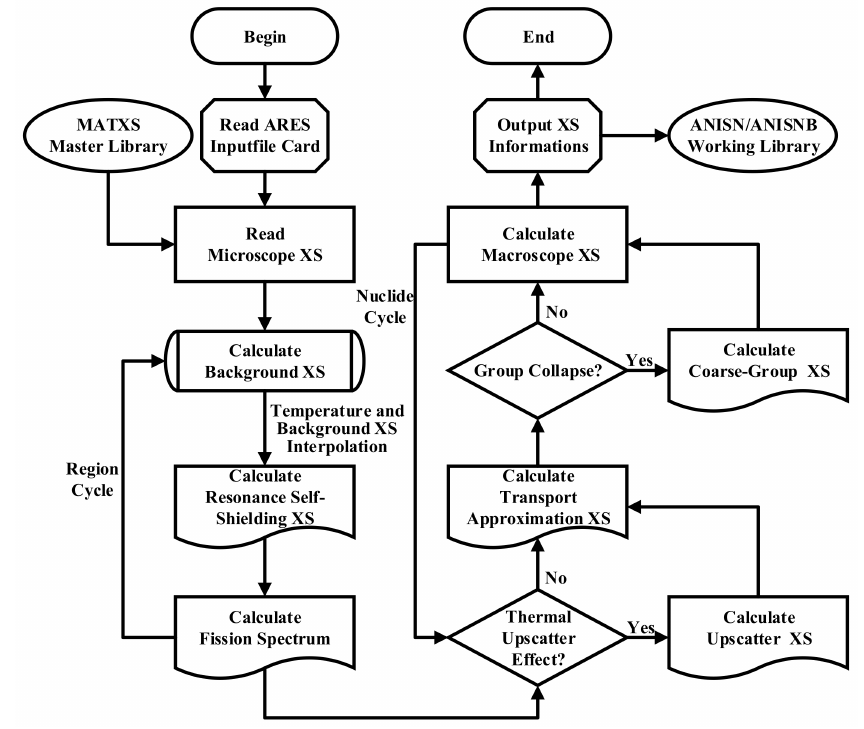
Figure 1. Flowchart of MGMXS module